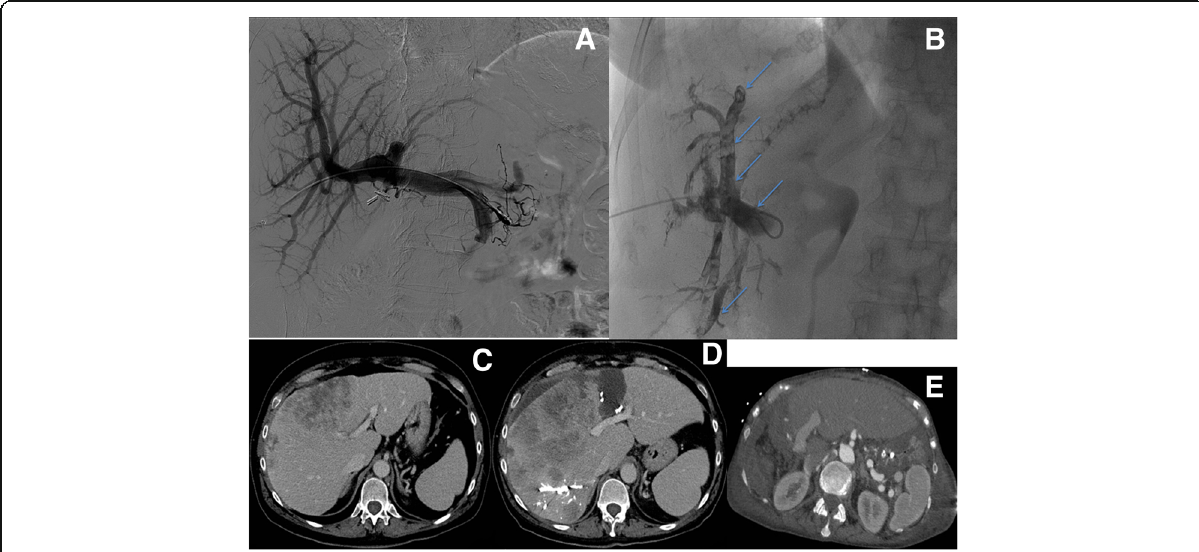
Fig. 1 Portal Vein Embolization (PVE) before right hepatectomy in a patient affected by Cholangiocarcinoma. a Preliminary portography before right PVE. b Right PVE using PVA particles and Squid-12 (light blue arrows). c Contrast enhanced CT pre-PVE showing an insufficient volume of left hepatic lobe. d Contrast enhanced CT post-PVE showing an increase of left hepatic lobe, with an increase of FLR-V of 71%. e Contrast enhanced CT post- right hepatectomy shows hypertrophy of the left hepatic lobe (FLR)